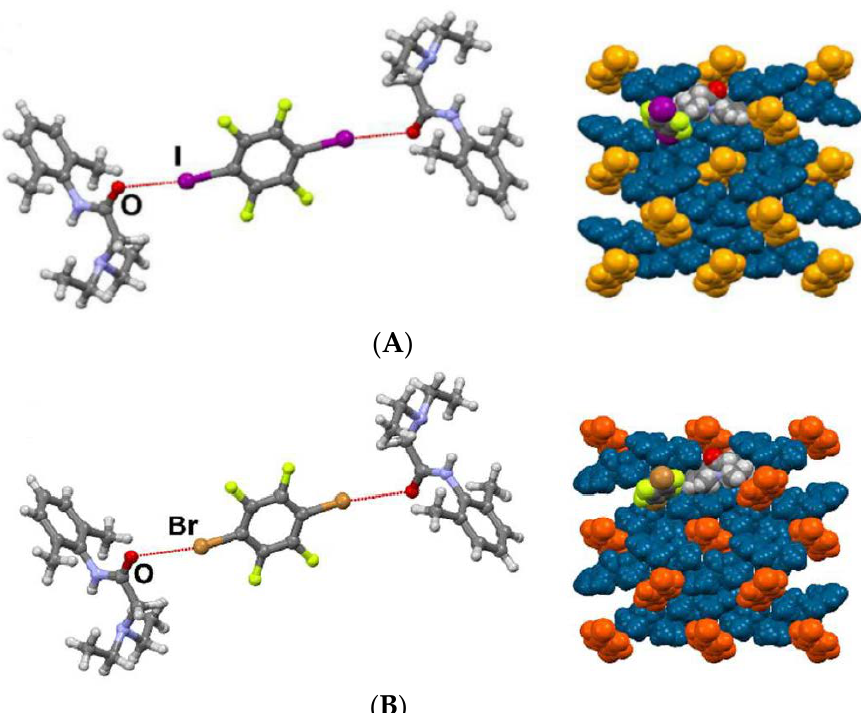
Figure 16. Supramolecular synthons observed in crystal structures of ( A ) lidocaine-1,4-